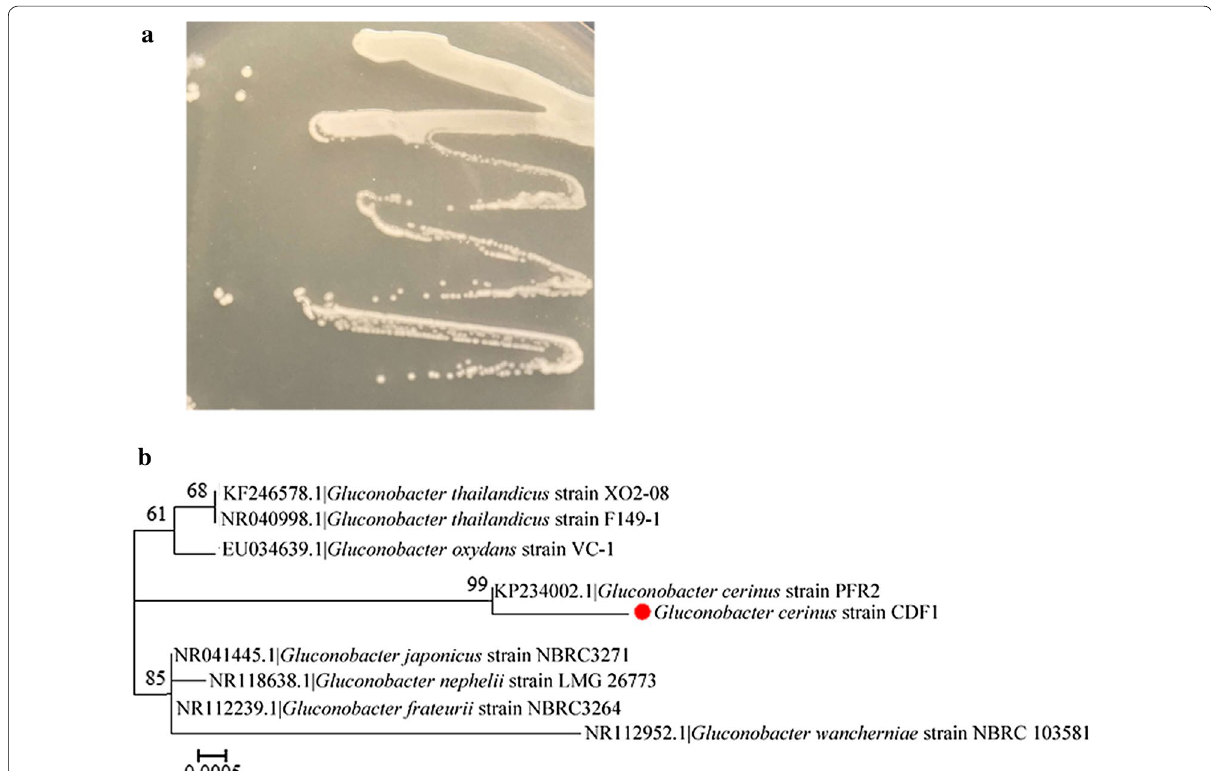
Fig. 3 Gluconobacter sp. isolation and identification. a Colony characteristics on agar plates for a bacterium isolated from the ovaries and eggs of flies. b Phylogenetic relationships of the symbiotic Gluconobacter cerinus strain CDF1. The red spot indicates the Gluconobacter cerinus strain CDF1. A maximum likelihood phylogeny inferred from 1377 aligned nucleotide sites in 16S rDNA gene sequences is presented with bootstrap values